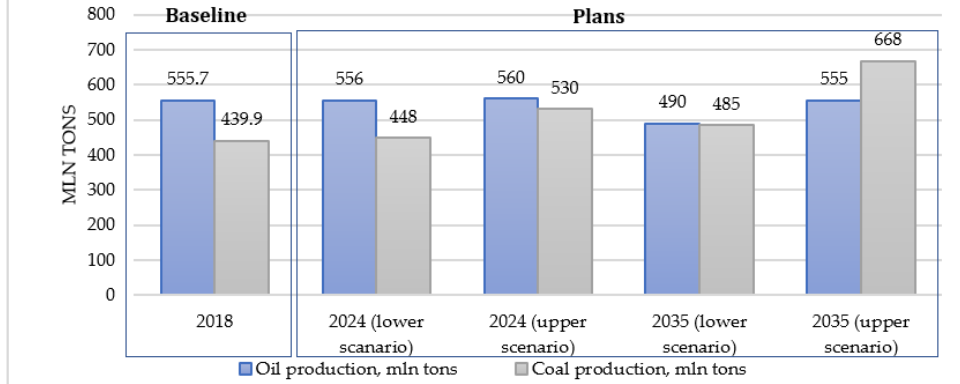
Figure 5. Oil and coal production scenarios according to the Energy Strategy of the Russian Feder- ation for the period up to 2035. Source: compiled by the authors based on [83,84]. for the period up to 2035. Source: compiled by the authors based on